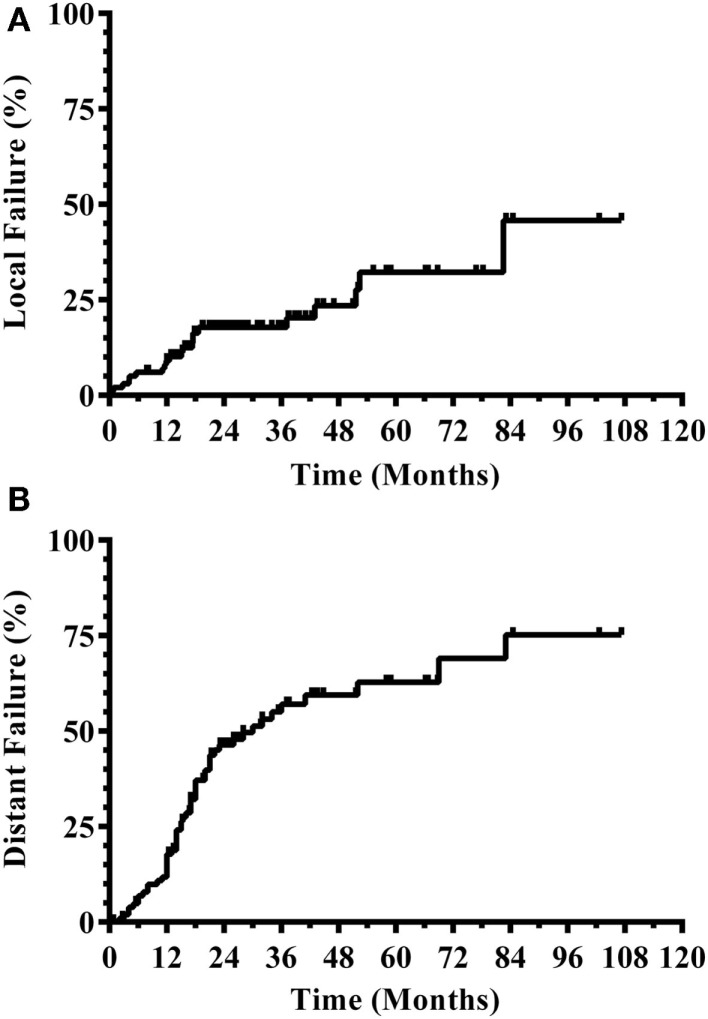
CNS disease outcomes for patients with ≥1 year WBRT-free survival. (A) Local progression. (B) Distant CNS progression (CNS, central nervous system; WBRT, whole brain radiation therapy).